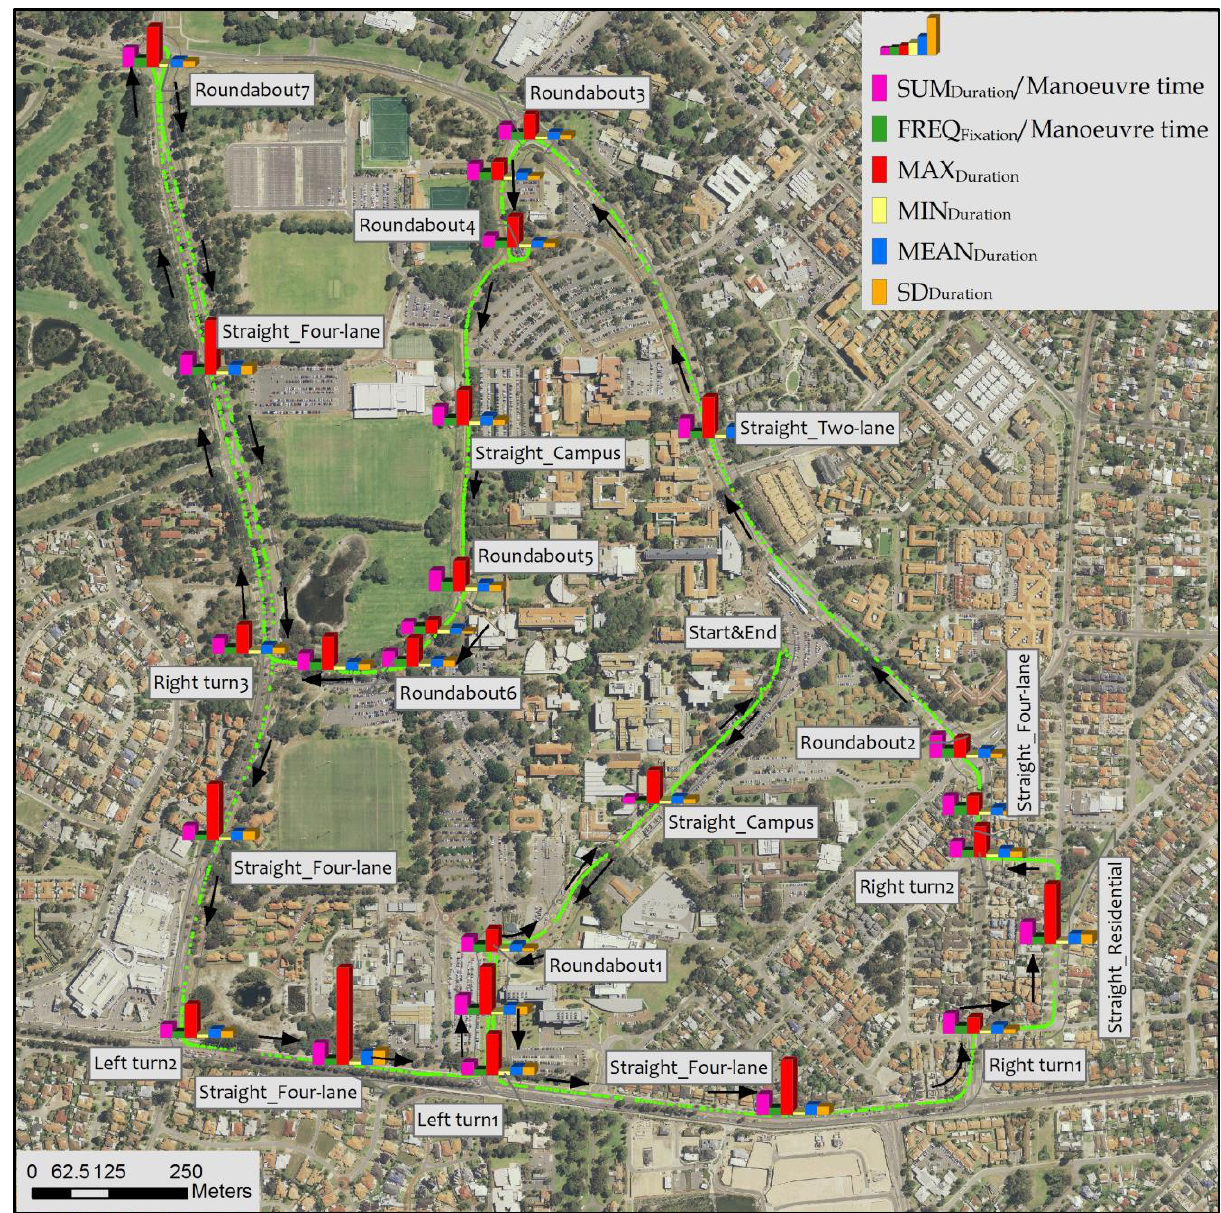
Figure 6. The spatial distribution of eye fixations for different driving manoeuvres and sections by an individual driver (driver C) using statistical parameters of the driver’s eye fixations. The green dots are the driver’s viewpoints related to eye fixation behaviour, namely the locations of the driver's gaze origin on the driving trajectory. Black arrows show the driving direction along the route. Figure 6 focuses on the statistical distribution of